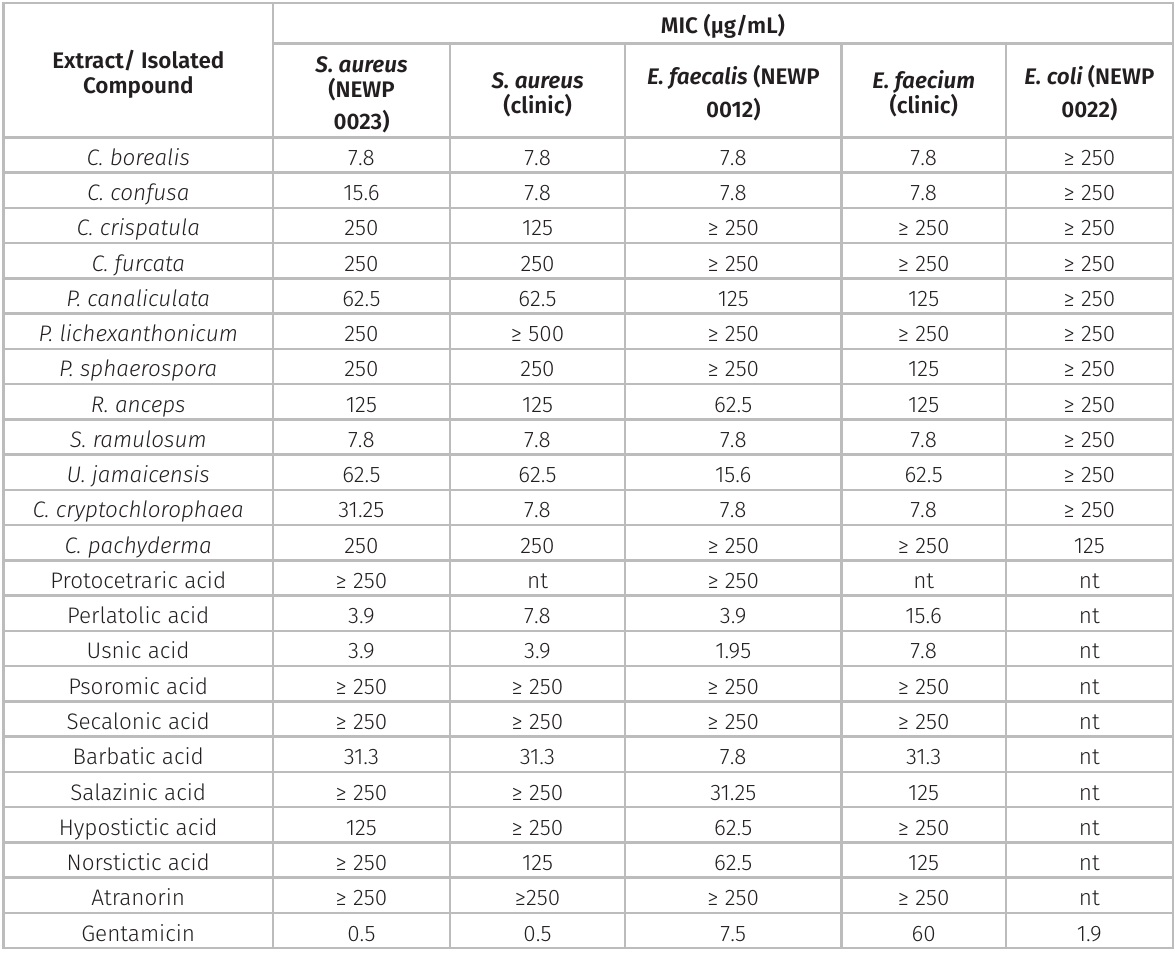
Table II. MIC values (µg/mL) for lichen extracts or isolated compounds against five bacterial strains.